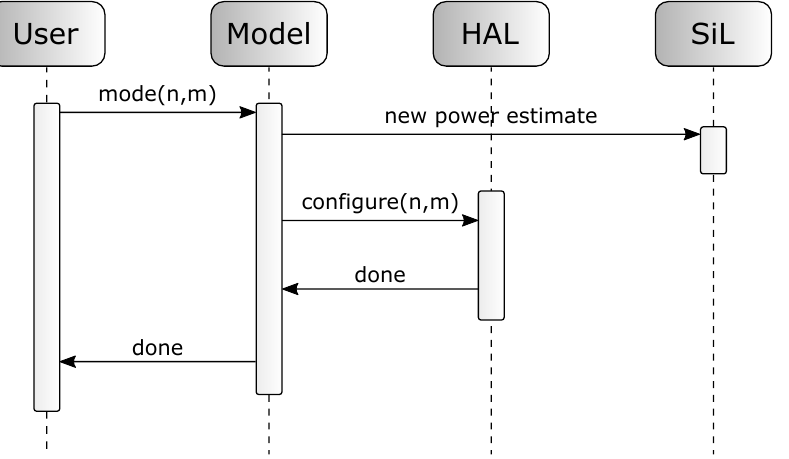
Figure 3. Sequence diagram of user–model